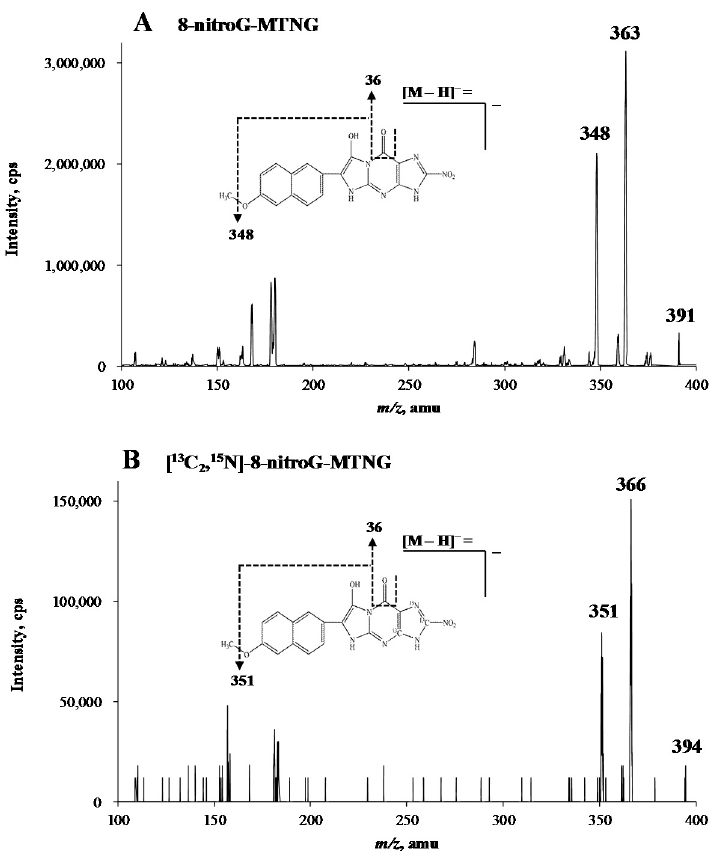
Figure 6. Negative ion electrospray MS/MS spectra of [M − H] − of 8-nitroG-MTNG ( A ) and [ 13 C 2 , 15 N]-8-nitroG-MTNG ( B ).